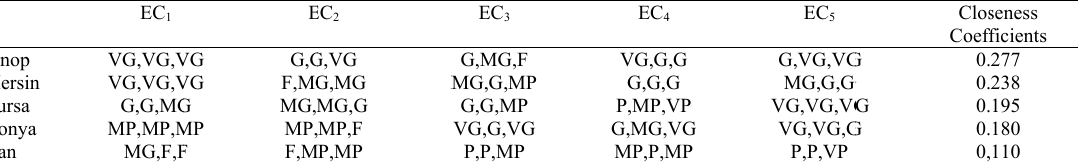
Figure 3. The strength and d as the bes ar power plan best strategic result for